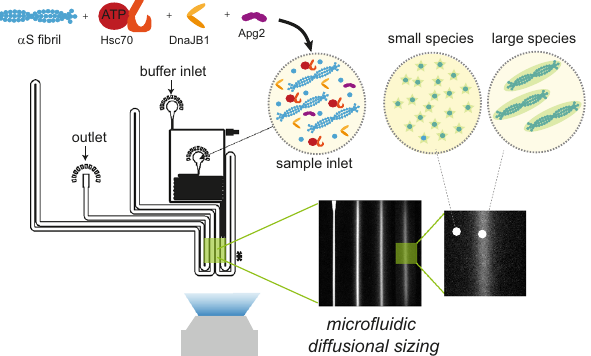
Fig. 1 Hsc70-mediated α S fi bril disaggregation monitored by direct size measurements through micro fl uidic diffusional sizing. α S fi brils are incubated with the Hsc70 – DnaJB1 – Apg2 chaperone triad. At different time points, the reaction mixture is analysed using micro fl uidic diffusional sizing which probes the sizes and hence molecular weights of the species present in the solution. From the recorded diffusion pro fi les, the size decay of fi brils with time is monitored, allowing kinetic and mechanistic analysis of the disaggregation